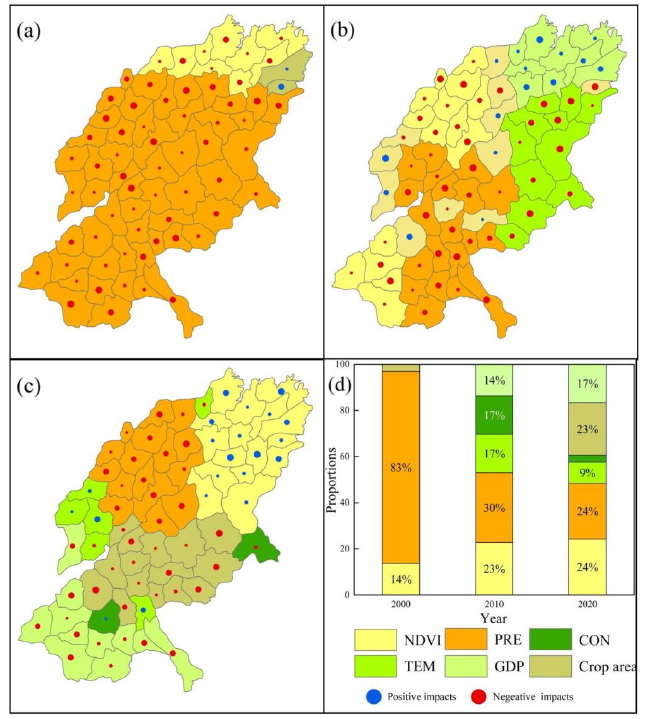
Figure 12. ESs’ trade-off drivers in different cities of FP_WY (( a ) in 2000; ( b ) in 2010; ( c ) in 2020). ( d ) Proportion of area accounted for by key ES trade-off drivers in different years (Refer to Tables 2 and 3 for the meanings of each symbol).